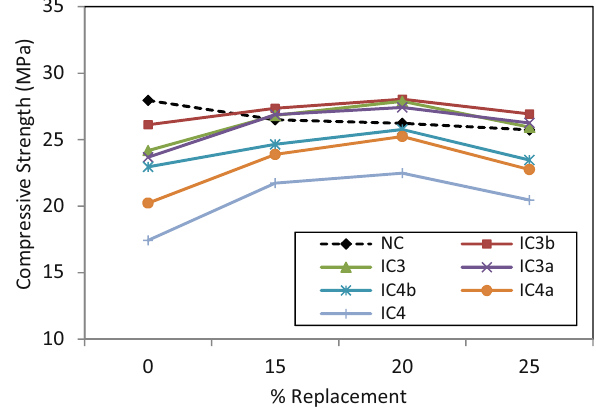
Fig. 12 Effect of percent replacement on compressive strength (Phase